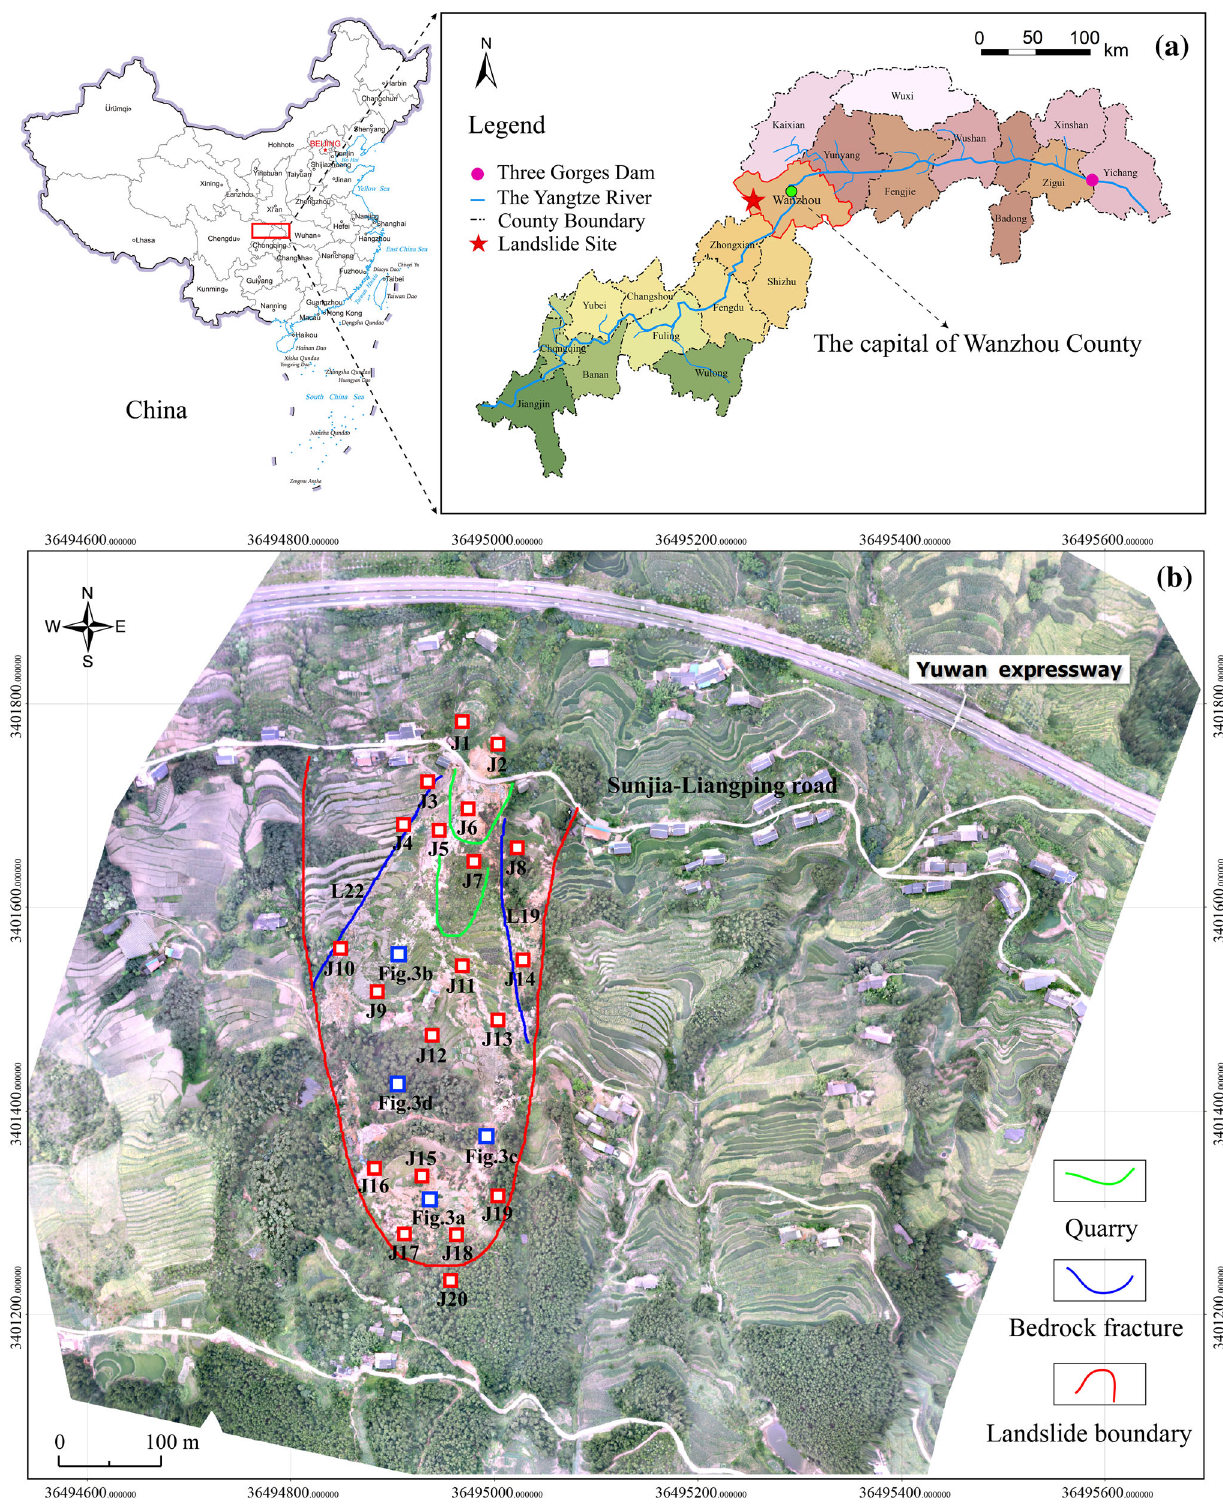
Fig. 1 Location of the Sunjia landslide, Wanzhou County, Three Gorges Reservoir, China. a Administrative map of the Three Gorges Reservoir region, China. b An aerial image of the post-slide Sunjia slope provided by the Nanjiang Hydrogeological Engineering